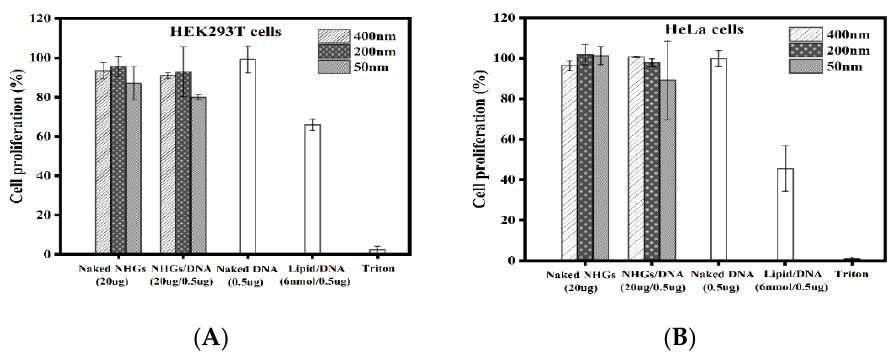
Figure 7. Cell proliferation for the different polyplexes (400, 200 nm and 50 nm) and control lipoplex at 48 h incubation in HEK293 T ( A ) and HeLa ( B ) cell lines. Each point represents the mean value ± SD (n = 2).